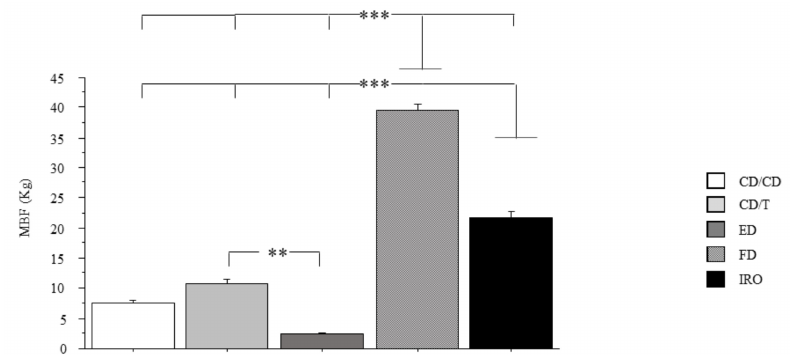
Figure 3. Bite force and prostheses. Maximal bite force in the three types of prostheses. MBF: maximal bite force; subjects with natural full dentition (FD); subjects wearing implant-retained overdentures (IRO); subjects with natural teeth in one arch and wearing traditional complete dentures (CD) in opposite dental arch (CD/T); subjects wearing CD in both arches (CD/CD); edentulous patients in both arches (ED). Data are the mean ± SEM. Asterisk (*) indicates significant difference between the groups. ** p < 0.01; *** p < 0.001.